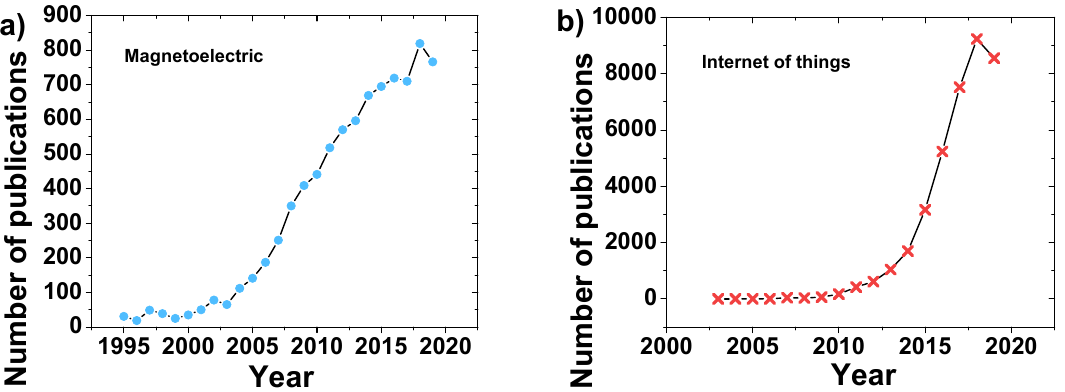
Figure 4. The publications per year according to the Web of Science database (7 / 2020) with the key words ( a ) magnetoelectric; and ( b ) internet of things [20] .